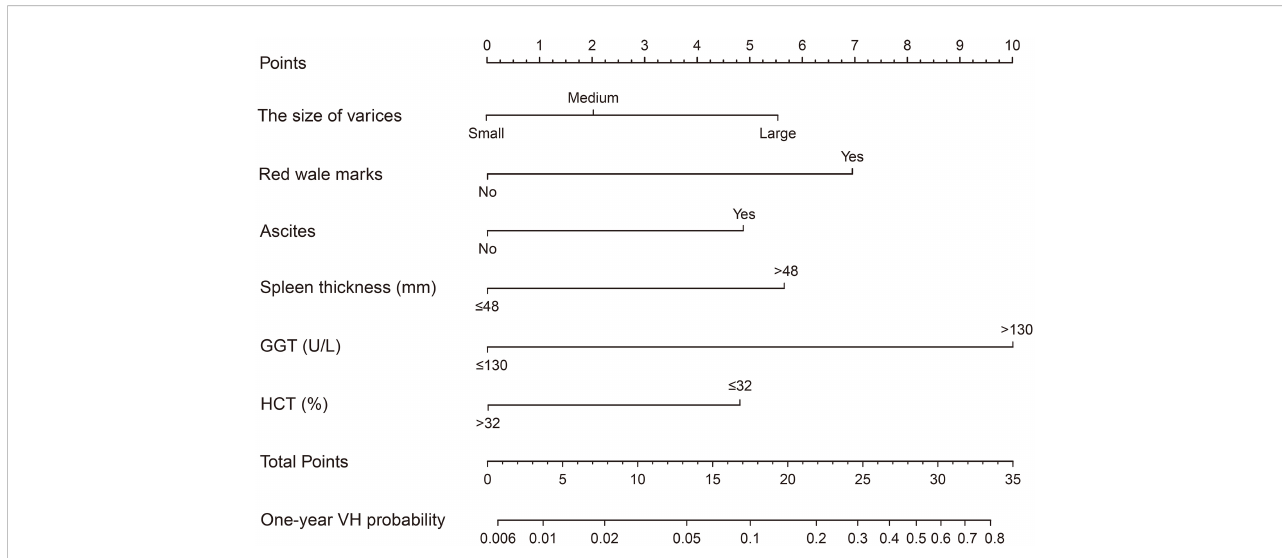
FIGURE 3 Nomogram for predicting the probability of VH within one-year in HBV-related cirrhotic patients with GEVs. The total points are calculated by adding the points of each covariate corresponding to the point on the upper pointing axis. A line is then drawn down to the probability axis at the bottom of the nomogram, which indicated the VH probability within one-year. Abbreviations: GGT, g -glutamyltransferase; HCT, hematocrit; VH, variceal hemorrhage; HBV, hepatitis B virus; GEV, gastroesophageal